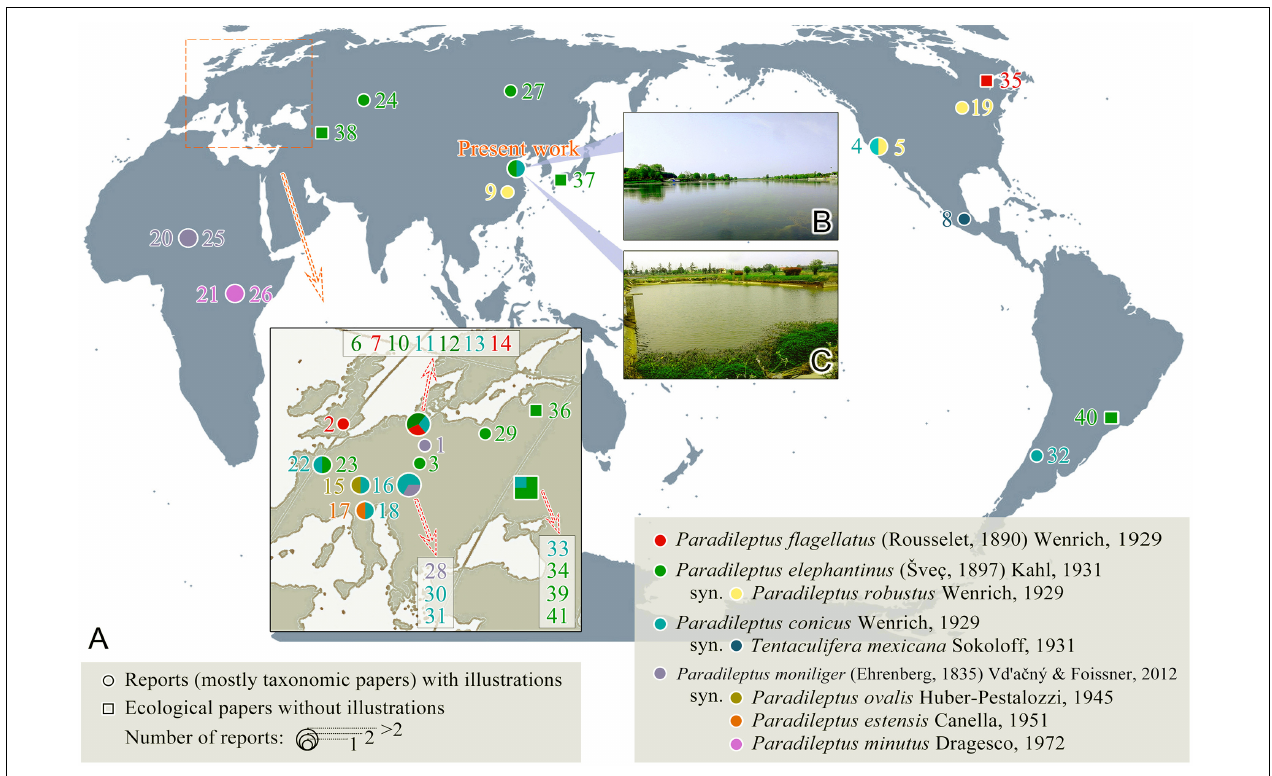
FIGURE 1 | (A) The global geographic distribution of four valid Paradileptus species (see Table 1 for details). (B) The sampling location of P. elephantinus (Chinese population). (C) The sampling location of P. conicus (Chinese population).